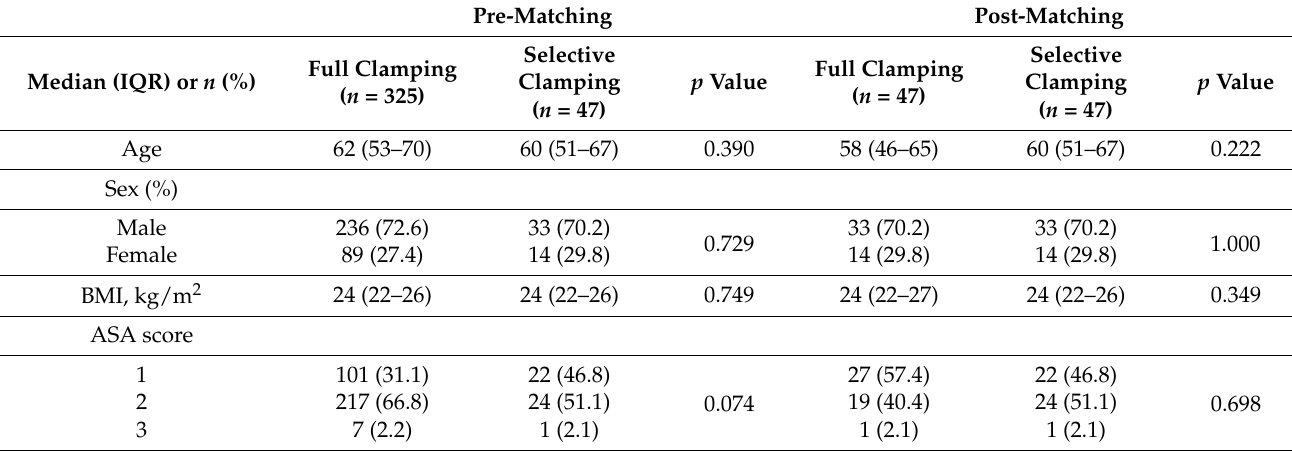
Table 1. Patients’ clinical